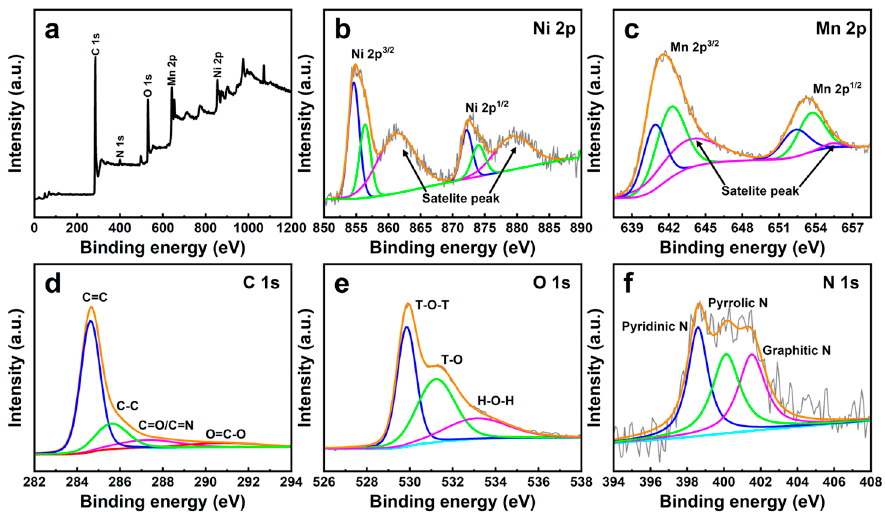
Figure 2. XPS spectra of Mn 3 O 4 /NiO/CNFs: ( a ) full wide-scan; ( b ) Ni 2p; ( c ) Mn 2p; ( d ) C 1s; ( e ) O 1s; and ( f ) N 1s.